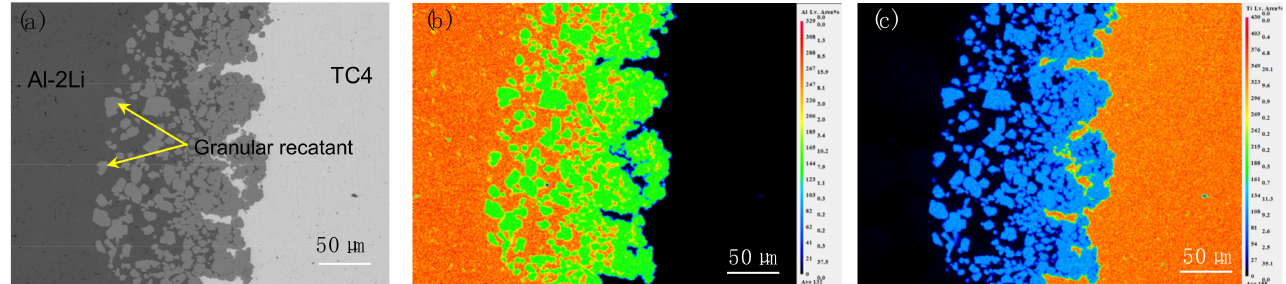
Figure 3. Element distribution on the interface ( a ) SEM photo; ( b ) Al; ( c ) Ti.